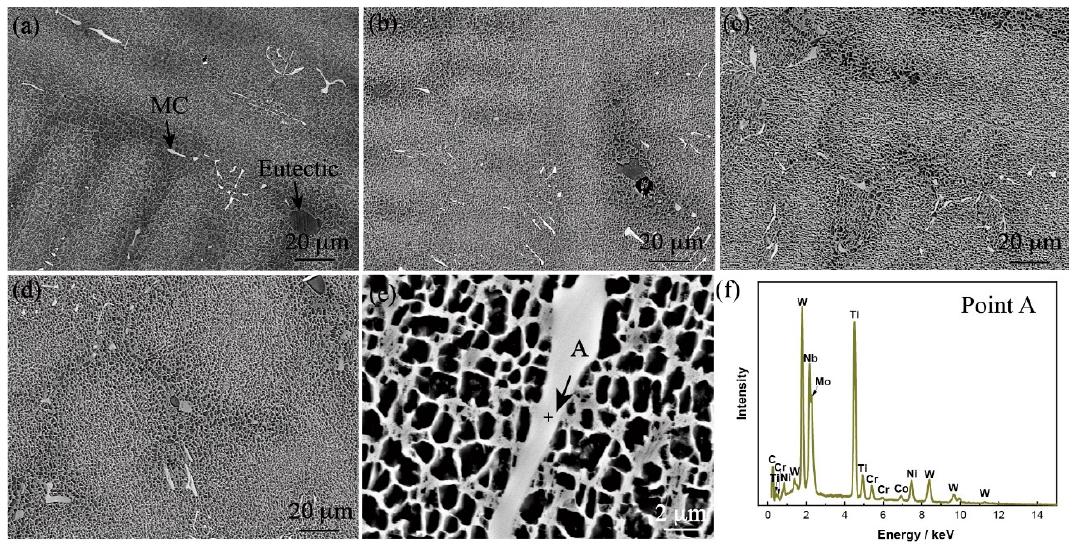
Figure 1. Microstructures of the as-cast high-W superalloys with different Mo content: ( a ) Alloy I, ( b ) Alloy II, ( c ) Alloy III, ( d ) Alloy IV, ( e ) magnified image of Alloy IV, ( f ) EDS result corresponds to the point A in ( e